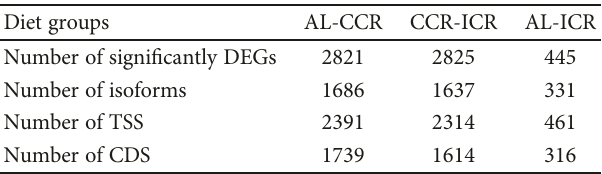
Table 3: Number of genes di ff erentially expressed between diet